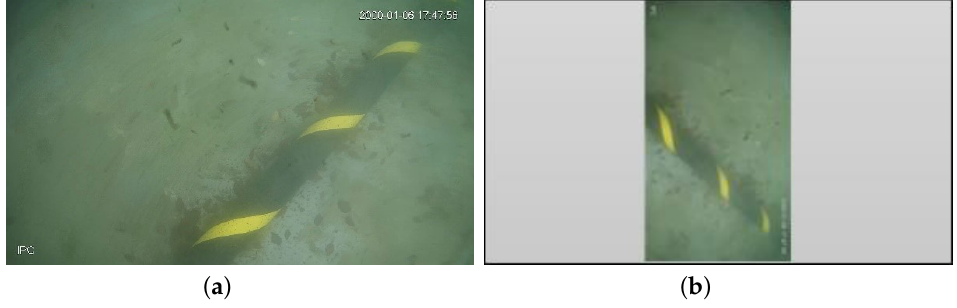
Figure 3. Part of the sample rotated 90 ◦ clockwise: ( a ) original image, ( b )